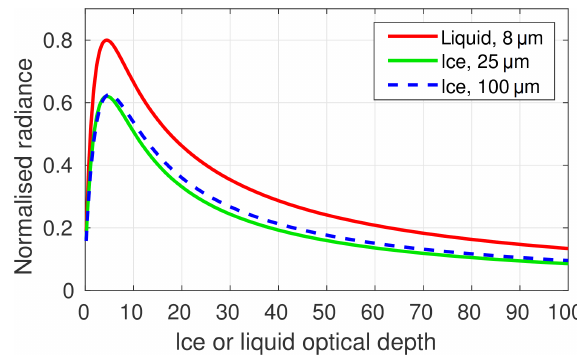
Figure 2. Normalised radiances extracted from the liquid (red) and ice (blue and green) look-up tables for a range of different optical depths, all calculated with unit top-of-atmosphere flux, for a solar zenith angle of 30 ◦ and at the visible 440nm wavelength over a surface albedo of 0.05. The numbers in the legend are values of liquid effective radius and ice effective